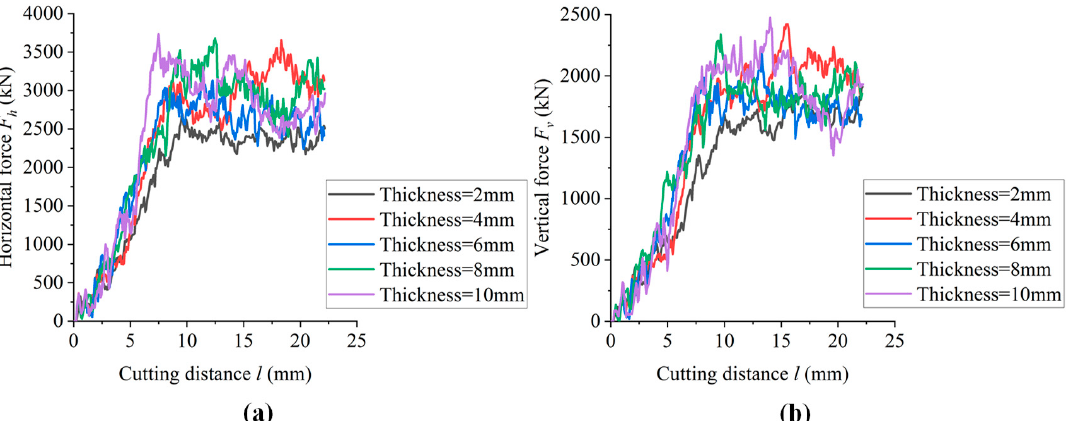
Figure 11. Cutting force vs. cutting distance curves for different bedding thicknesses. ( a ) Horizontal component vs. cutting distance; ( b ) vertical component vs. cutting distance.